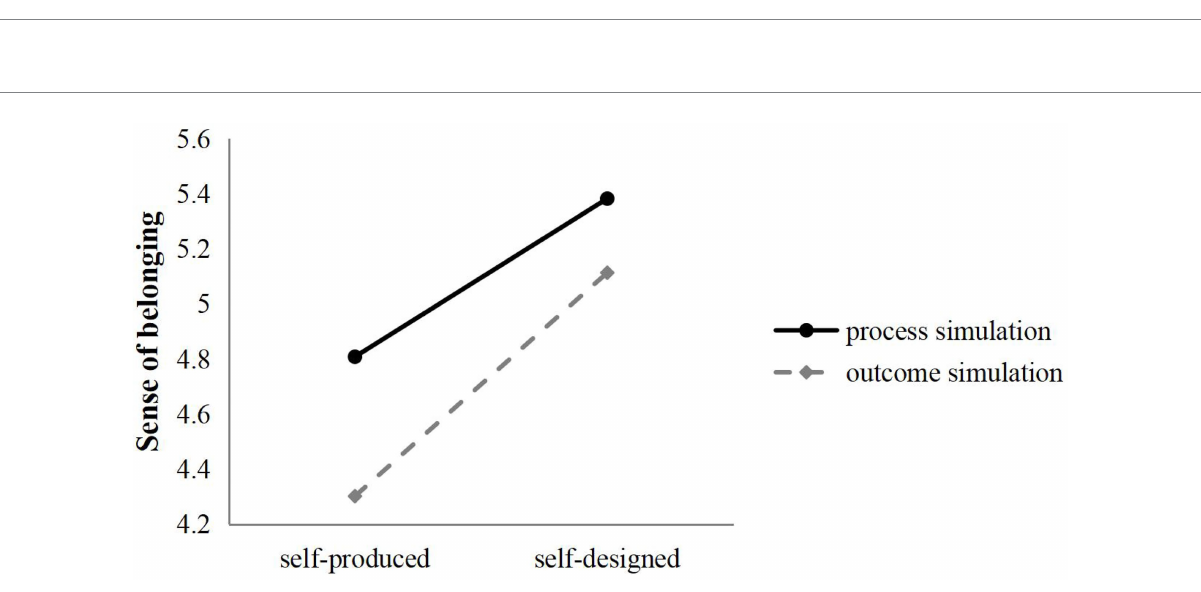
FIGURE 4 Moderating effect of mental simulation (sense of belonging).